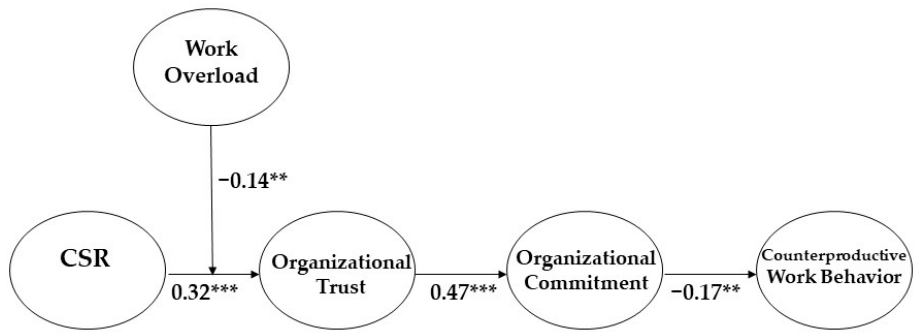
Figure 2. The final results of the research model. ** p < 0.01, *** p < 0.001